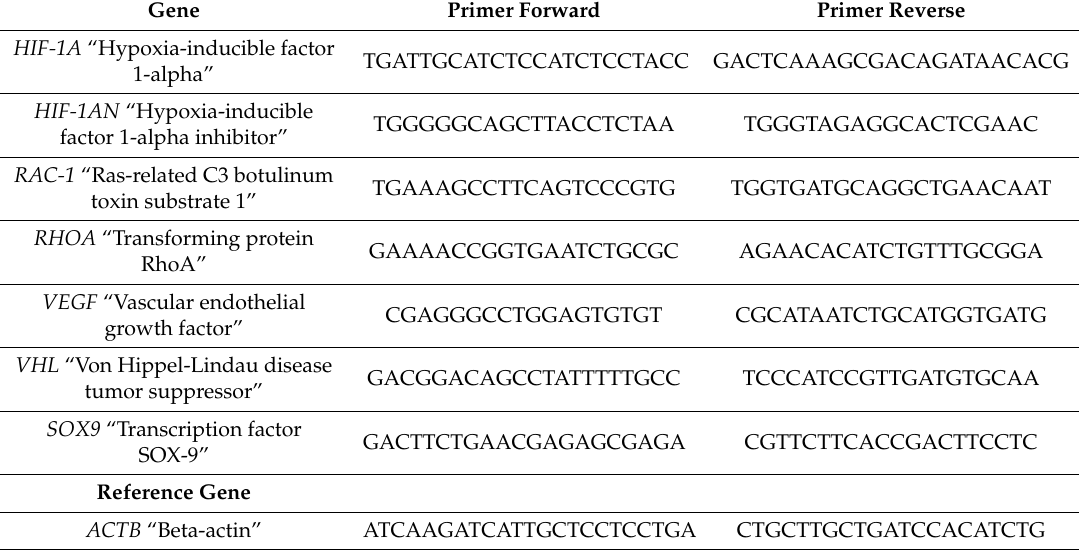
Table 1. List of gene primers used to study gene expression profiling.